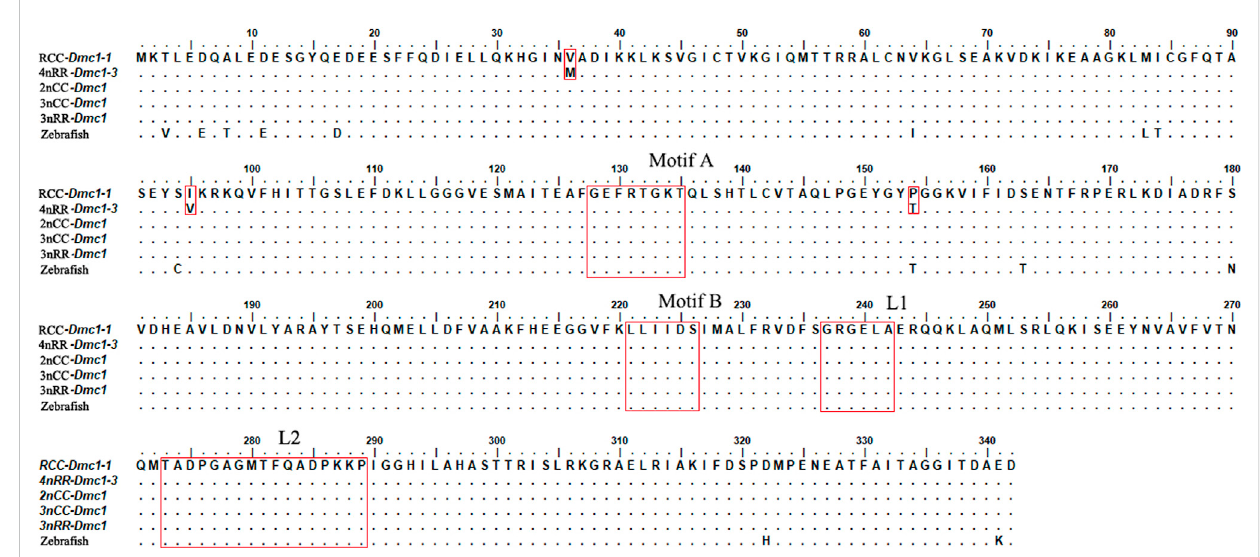
FIGURE 3 Aligned amino acid (aa) residues of the Dmc1 genes in RCC, 4nRR, 2nCC, 3nCC, 3nRR, and zebra fi